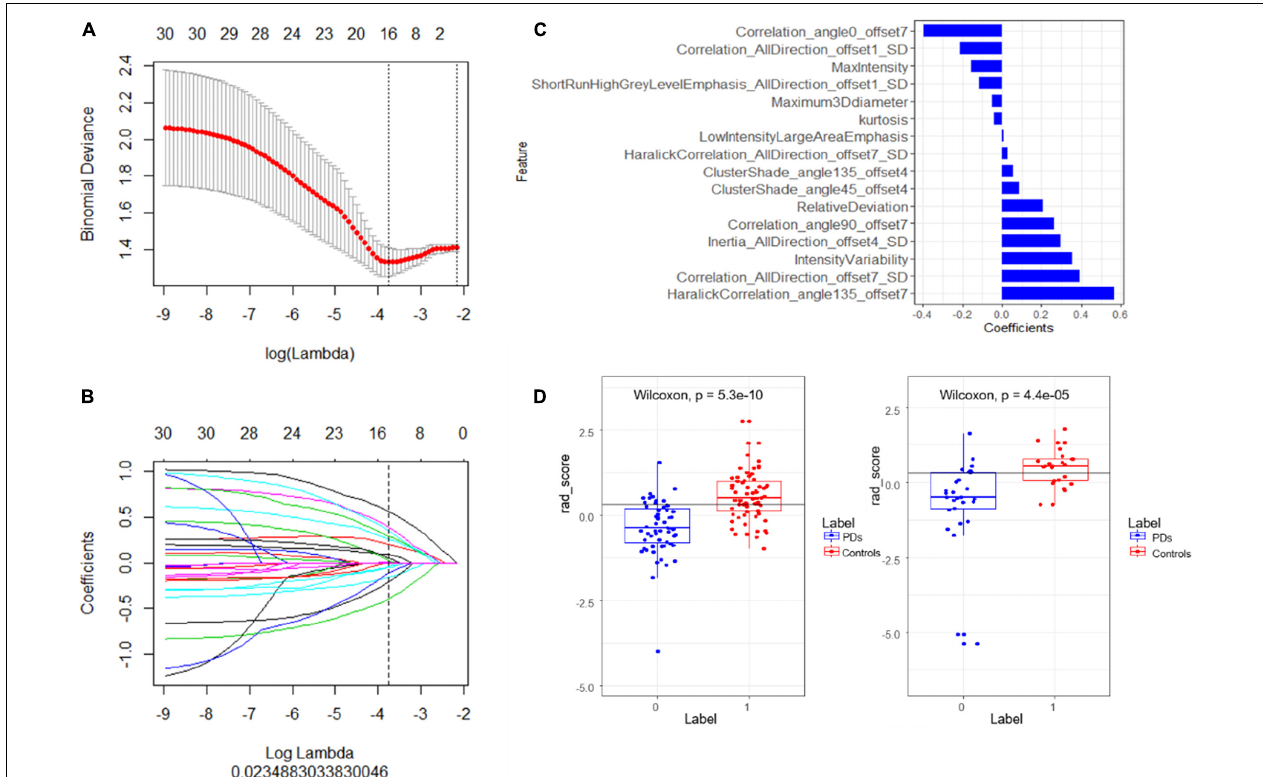
FIGURE 2 | (A) Tuning parameter ( λ ) selection in the LASSO model using 10-fold cross-validation via minimum criteria. Binomial deviances from the LASSO regression cross-validation model are plotted as a function of log ( λ ). The coefficients vary by log ( λ ), the dotted vertical lines were drawn at the optimal values using the minimum criteria and the 1-SE criteria. (B) The LASSO coefficient profiles of 16 features with non-zero coefficients are shown in the plot. (C) The retained non-zero coefficients features are plotted on the y -axis and their coefficients in the LASSO Cox analysis are plotted on the x -axis. The rad-scores of each patient were calculated and classified into PD and control class according to the cutoff value 0.31. (D) Patients with a rad-score less than 0.31 represent the true classification of PD patients, bigger than 0.31 means PD patients were falsely classified into the control class. The Wilcoxon test shows there is a significant difference of the model in classifying the patients into these two classes.